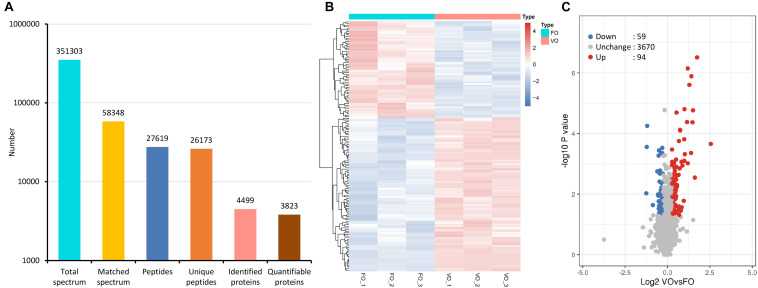
Tandem mass tag (TMT)-based quantitative proteomic sequencing results. (A) Summary of tandem mass spectrometry database search analysis. (B) A heatmap with hierarchical clustering of differentially expressed proteins (DEPs). In the heatmap, the expression of DEPs in different samples is shown with different colors, with red indicating high expression and blue indicating low expression. Each line represents a protein, and each column represents a group of samples. (C) A volcano plot of DEPs. Proteins with fold change of ≥1.20 or ≤0.83 and p-value < 0.05 were considered statistically significant. Red dots indicate significant up-regulated proteins, blue dots indicate significant down-regulated proteins, and gray dots indicate proteins without differences. The X-axis represents fold change, and Y-axis means p-value. FO, fresh oocytes; VO, vitrified oocytes.